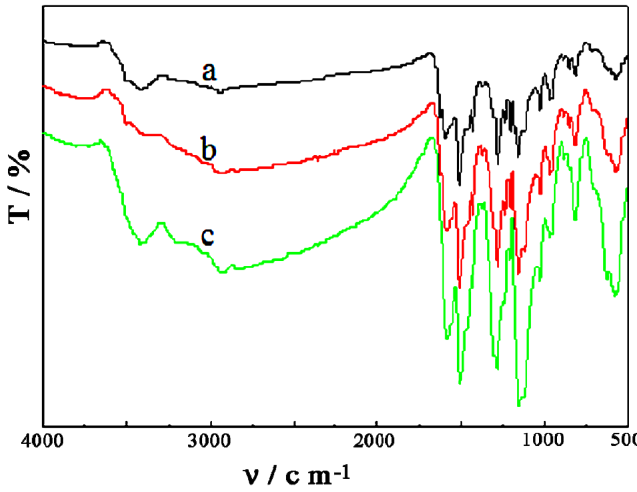
Figure 3. FT-IR spectra of γ-Fe 2 O 3 /PANI-curcumin with different molar ratios between γ-Fe 2 O 3 /PANI and curcumin: γ-Fe 2 O 3 /PANI:curcumin = ( a ) 1:2; ( b ) 1:1; and ( c )